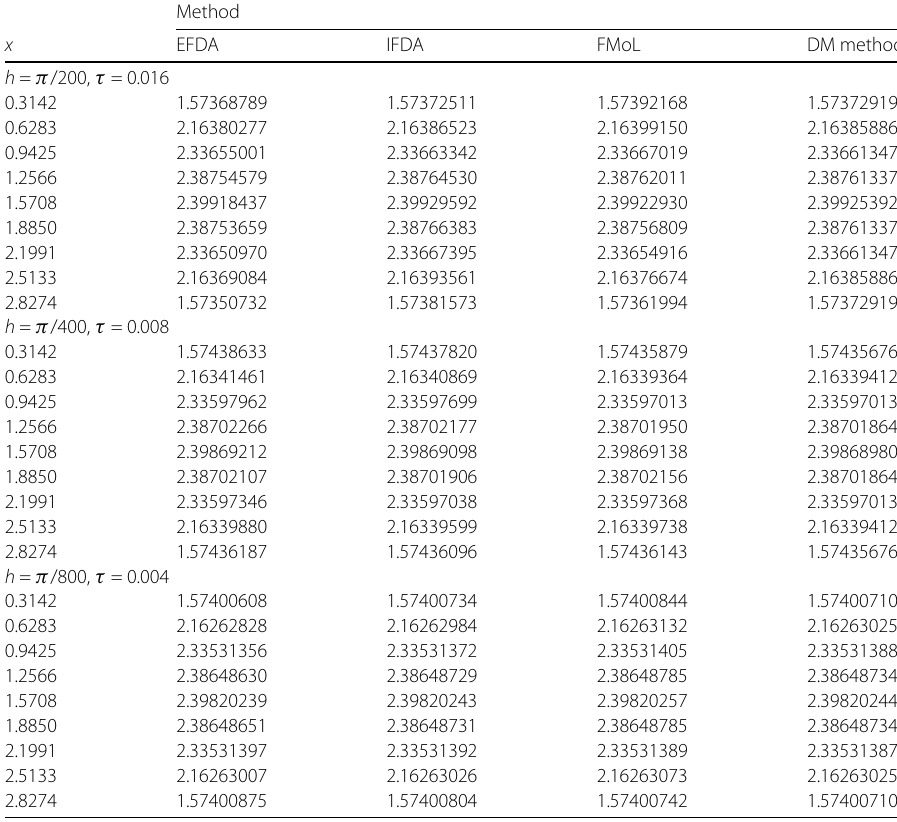
Table 3 Values of the approximate solution of problem (57) at different values of x and T = 3, using Ω = (0, π ), α = 1.8, and K = 0.1. Computationally, we used different combinations of values of h and τ . The results were obtained using the EFDA, IFDA, and FMoL reported in [36], as well as the DM method introduced in the present manuscript Method x EFDA IFDA FMoL DM method h = π /200, τ = 0.016